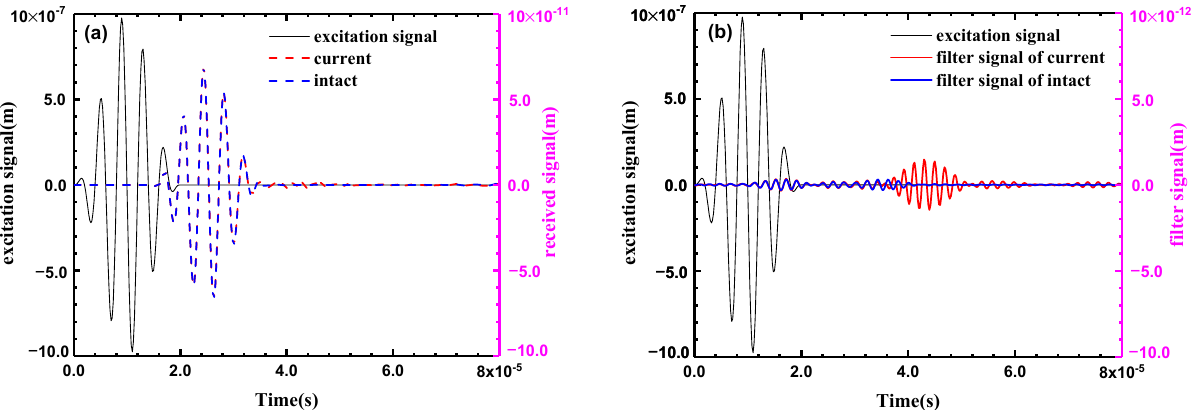
Figure 11. The excitation signal (left ordinate) and ( a ) the Lamb wave signal (right ordinate) and ( b ) the Lamb wave signal with a band pass filters (right ordinate) received from the sensing path AB in the intact and the current state.